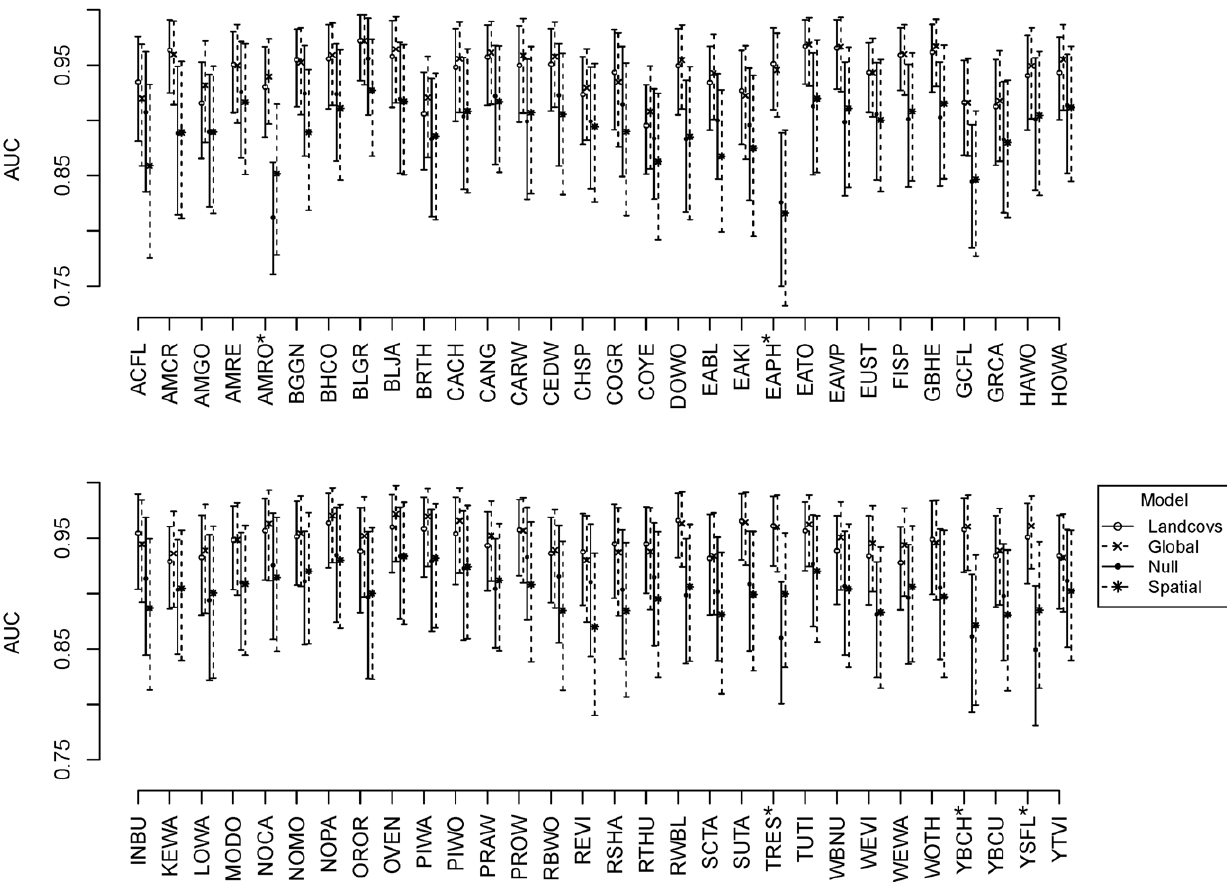
Figure 2. Fit of alternative models describing distributions of bird species sampled on the Patuxent Wildlife Research Refuge. Models included the following: null=species-specific occupancy, assumed to be constant across all sampling locations, landcovs=six landcover covariates for species-specific occupancy, spatial=autologistic covariate for species-specific occupancy, and global=landcovs and spatial combined. All models account for imperfect detection of species. Symbols represent the mean AUC values and whiskers represent the 95% Bayesian credibility intervals (BCIs) of the AUC estimates. An asterisk (*) following the species code indicates that the landcover model had significantly better fit than the null model.